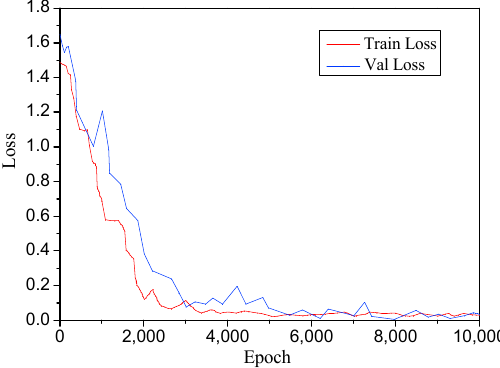
10 of 14 Figure 5. Loss curve: comparison of proposed non-BP and BP algorithm in the training process. Figure 4 shows that the traditional BP-based method did not reach convergence at